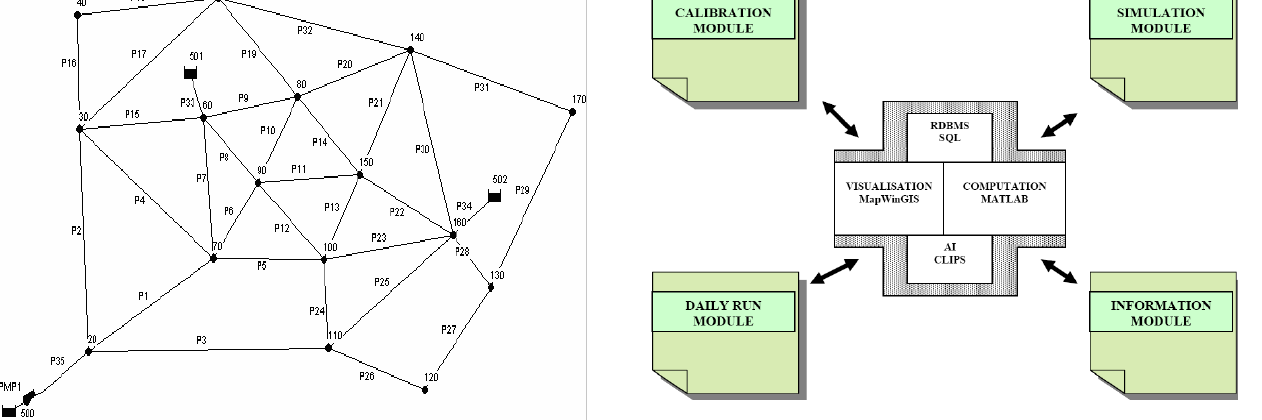
Figure 1. The anytown network.